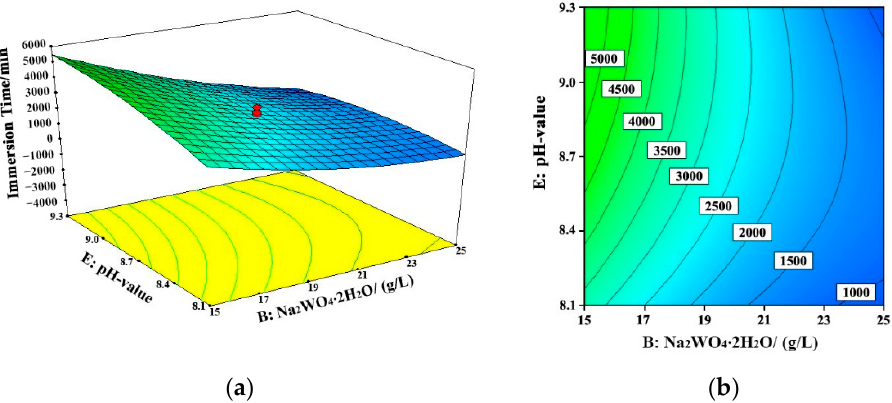
Figure 7. Response surface ( a ) and contour map ( b ) of the coating failure time with the changes of sodium tungstate concentration and bath pH (nickel sulfate concentration = 25 g/L, sodium hy- pophosphite concentration = 25 g/L, 60 ◦ C). B : Na 2 WO 4 · 2H 2